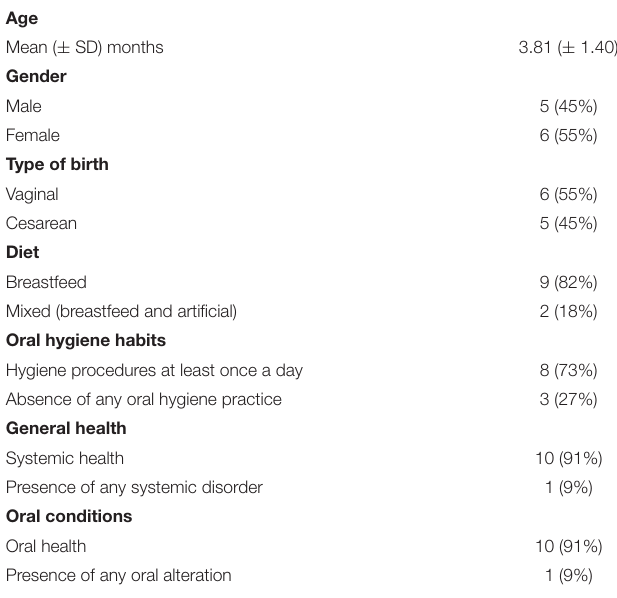
TABLE 1 | Characterization of the